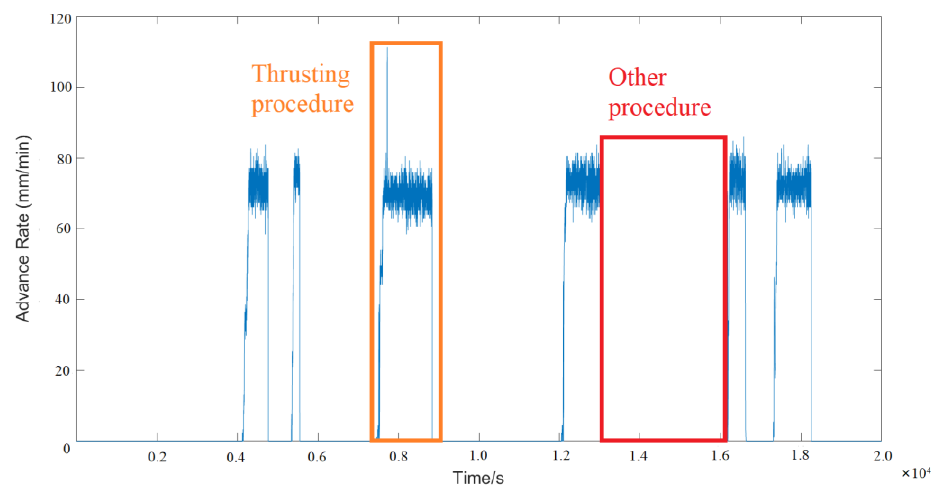
Figure 6. TBM advance rate during operation.